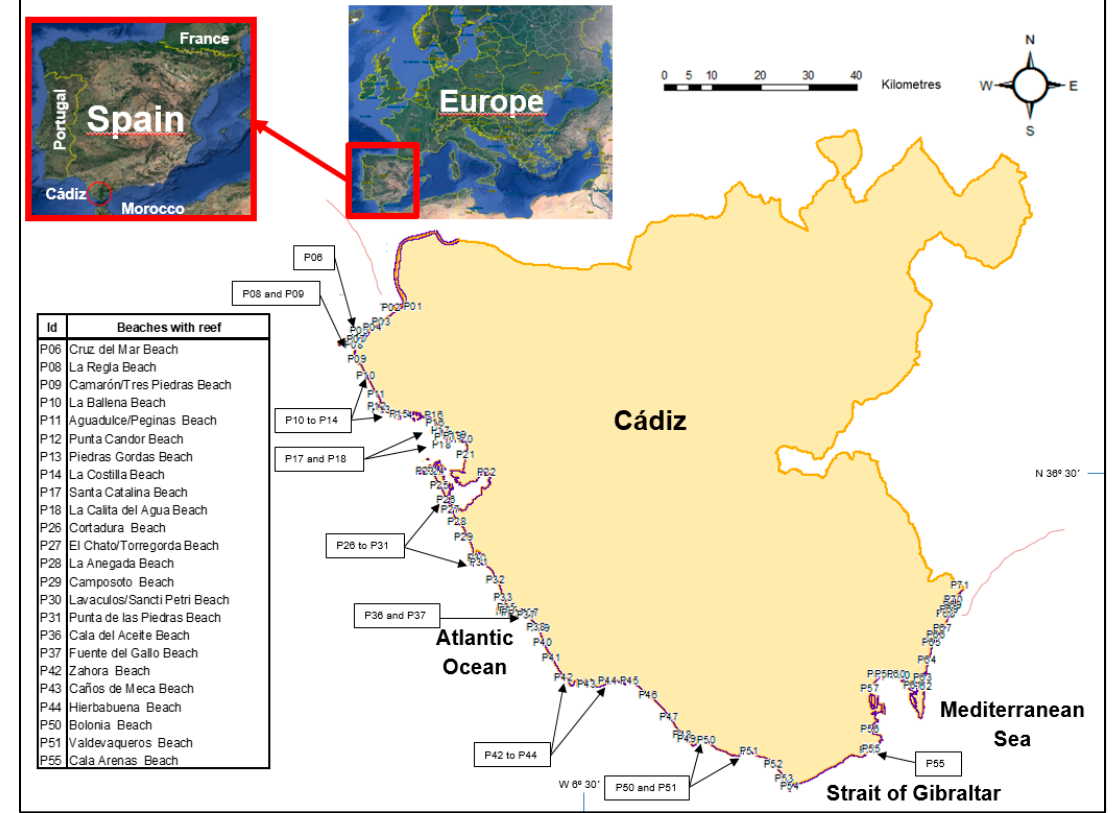
Figure 2. Location of the 25 reef flat beaches (from a total of 71) analysed in this study.